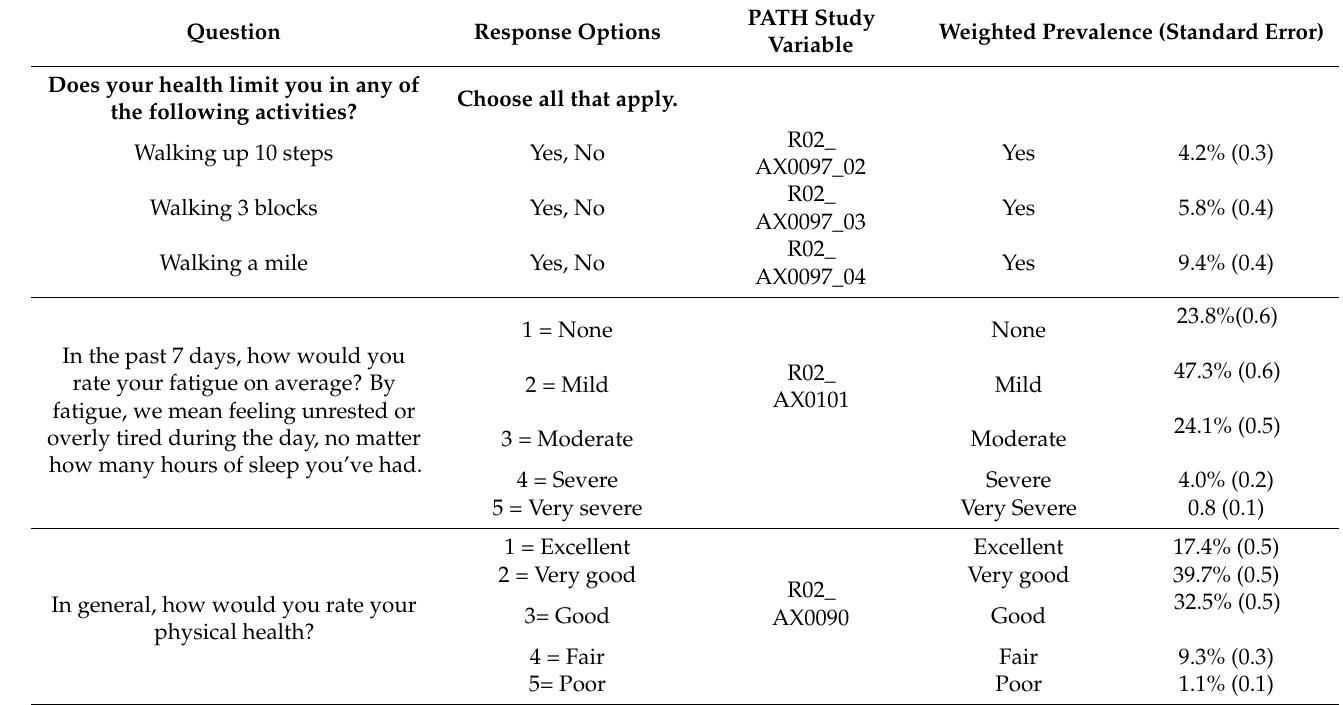
Table 3. Questions related to health and functional status for Wave 2 (2014–2015) of the PATH a Study. Question Response Options